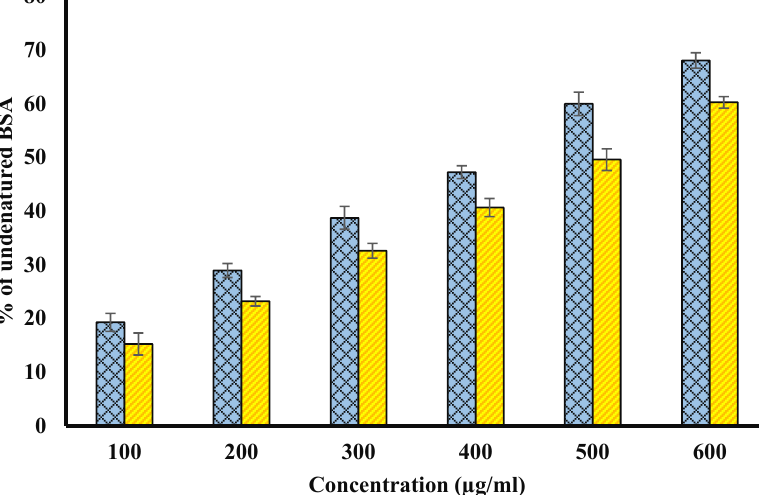
Figure 4. Percentage of undenatured BSA. Blue bars show percentage of undenatured BSA plot for various concentrations ( µ g/mL) of fruit pulp. However, yellow columns show the percentage of undenatured BSA plot for various concentrations ( µ g/mL) of seed extract. The p -value significance was found to be less than 0.05 for this figure ( p < 0.05).